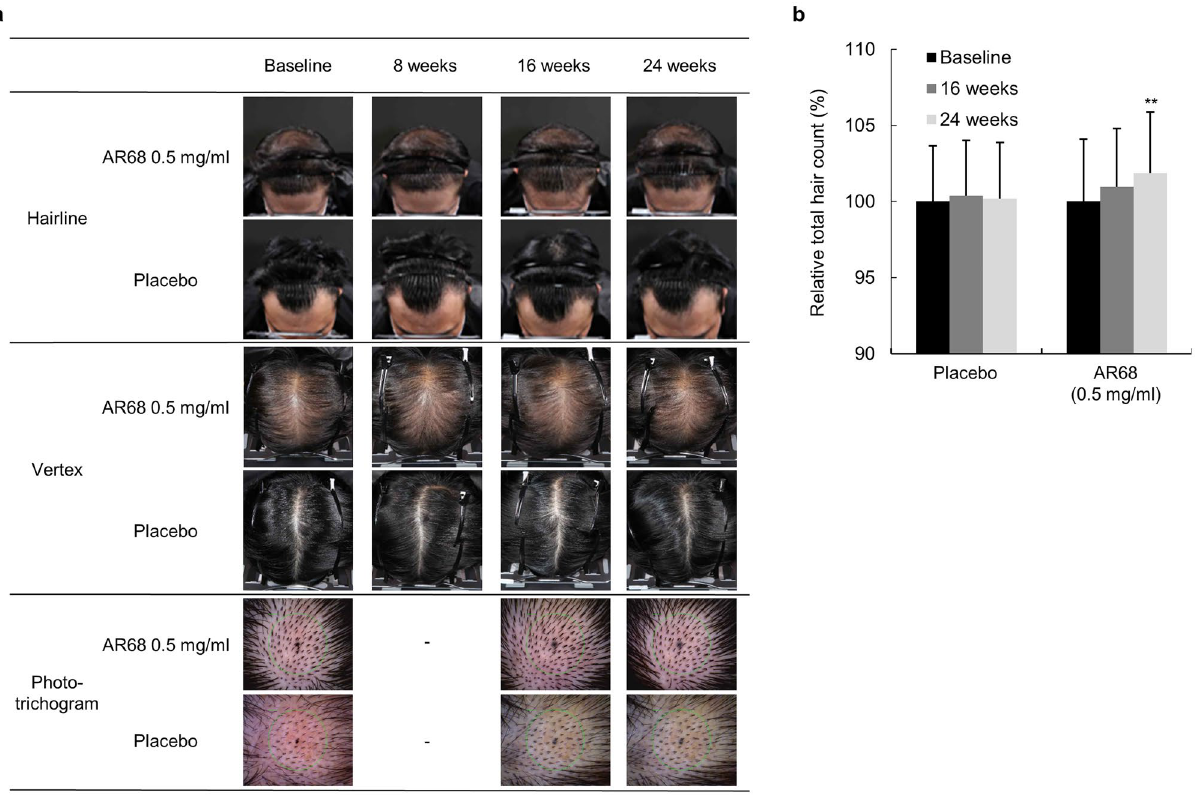
Figure 5. Images of the change in hair loss following 24 consecutive weeks of application of SAMiRNA-AR68 at 0.5 mg/ml and placebo products. ( a ) Representative photographs of the forehead hairline and vertex of the two groups at baseline and 8, 16 and 24 weeks after 0.5 mg/ml AR68 and placebo treatment three times per week. The phototrichogram analysis was performed at baseline and at 16 and 24 weeks. ( b ) Representative graph of the percentage of total hair count increments at 16 and 24 weeks compared to baseline.